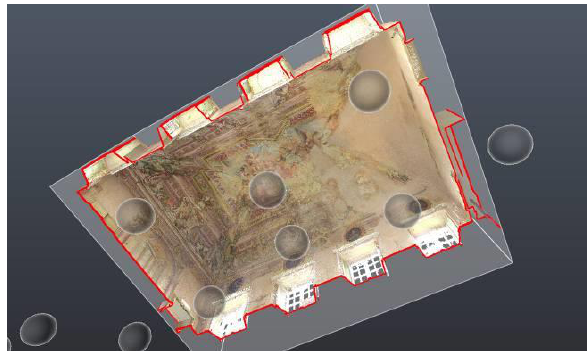
Figura 14. RGB three-dimensional view – 3d model of the vault elaborated with laser